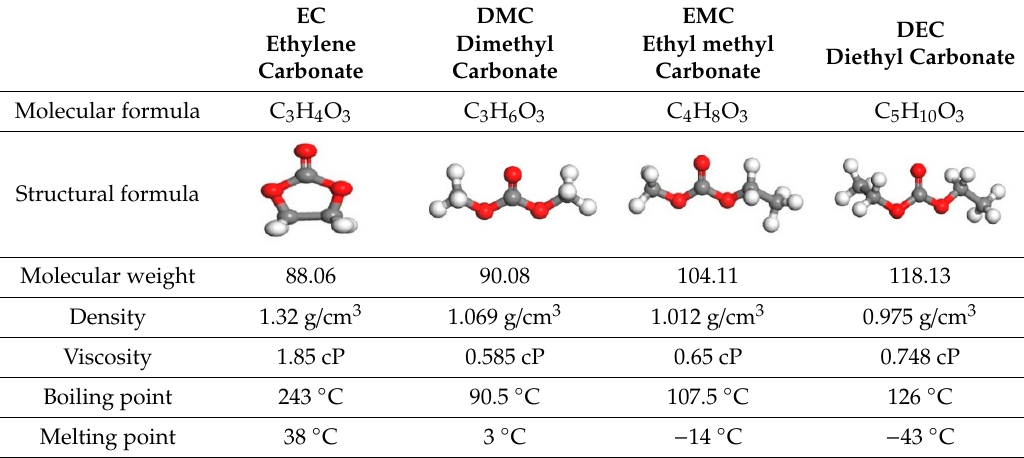
Table 1. Chemical structures and properties of the cyclic and linear carbonate solvents.